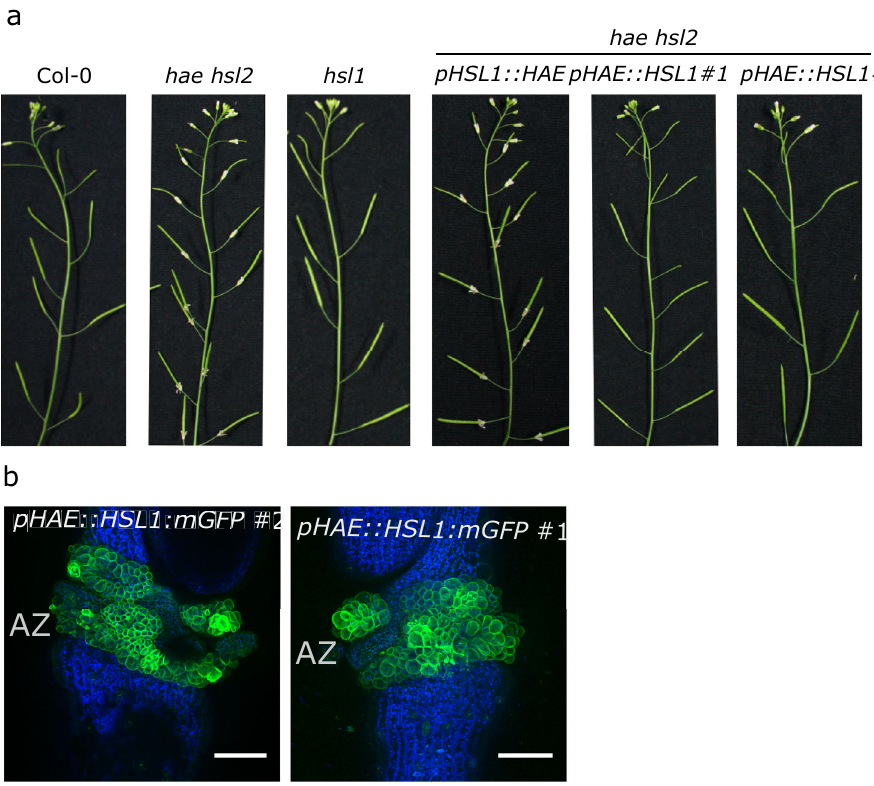
Fig. 4 The LRR-RK HSL1 can mimic HAESA, acting as a positive regulator of fl oral abscission. a HSL1, which is not typically expressed in abscission zone (AZ), can perceive IDA in vivo and replace the receptor HAESA in fl oral shedding. Abscission complementation assays of hae hsl2 double mutant expressing the receptor HSL1 under the HAESA promoter. As control, the HAESA receptor was expressed under the HSL1 promoter. A minimum of two independent lines were analyzed for fl oral abscission phenotype. Wilt type Col-0, and hae hsl2 and hsl1 mutants were also phenotyped alongside. b Localization of HSL1 in AZ under the expression of the HAESA promoter. Confocal images of AZ of pHAESA::HSL1::mGFP lines. Scale bar = 100 μ